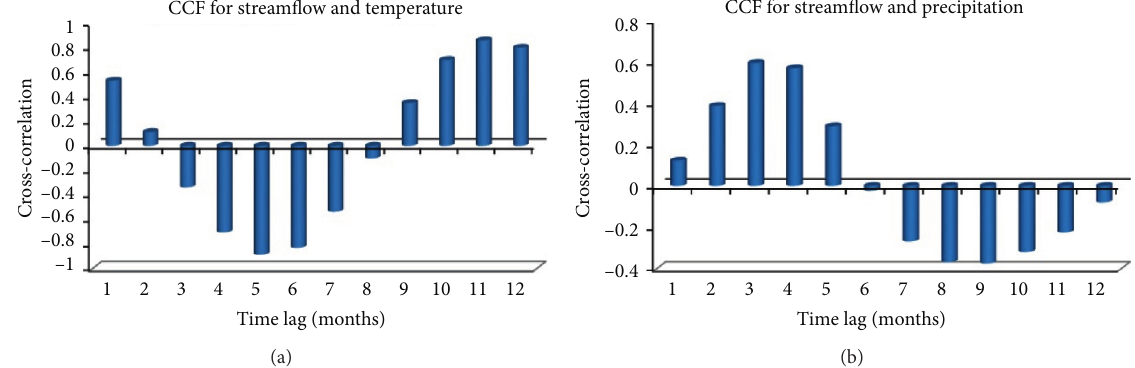
Figure 8: Cross-correlation function. (a) Streamflow and temperature. (b) Streamflow and Table 2: Comparison of models using statistical metrics during the training period. Model MAE (m 3 /s) RMSE (m 3 /s) NSCE MAPE (%)